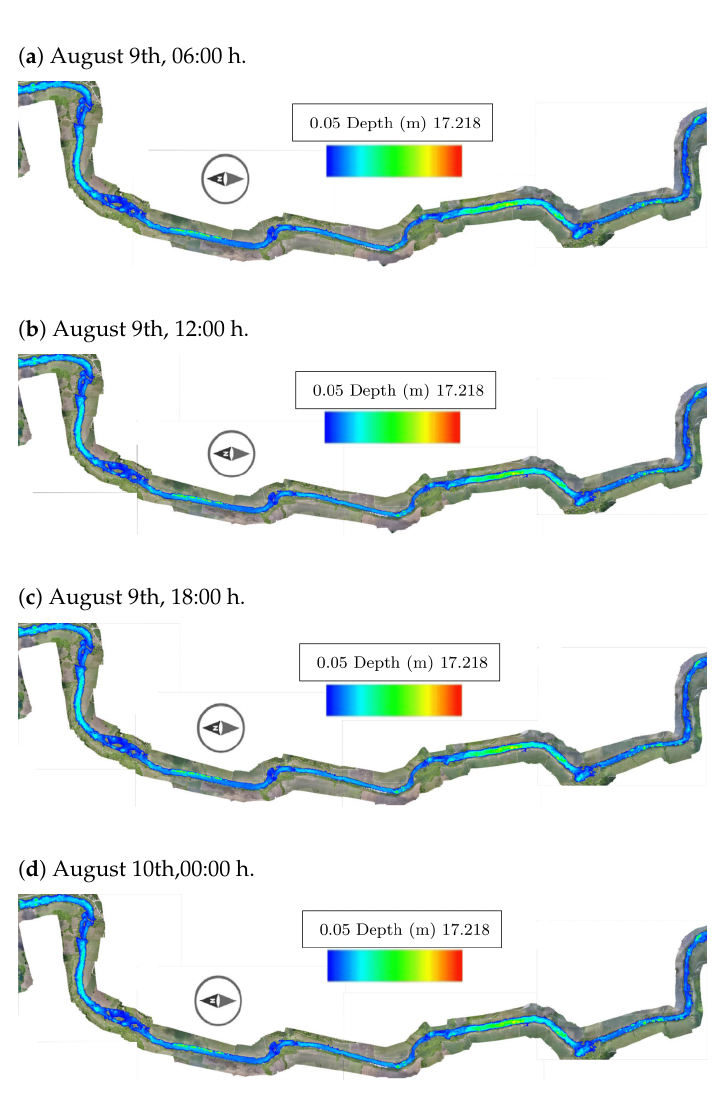
Figure 15. Depths for scenario